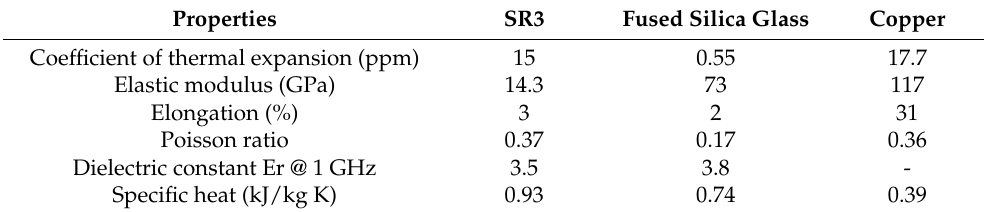
Table 1. Specifications of the materials.